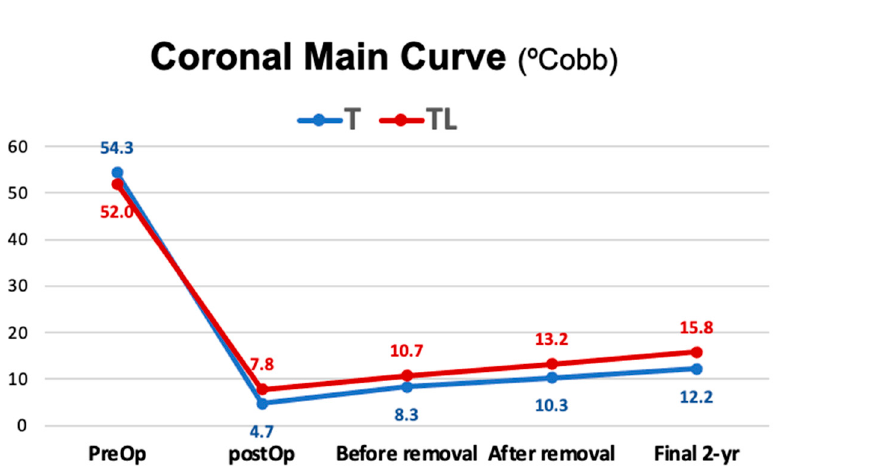
Figure 4. Correction of the main coronal curve during follow-up. A correction of 89.7% was achieved after surgery, and a 75.4% correction was achieved at two years’ follow-up.